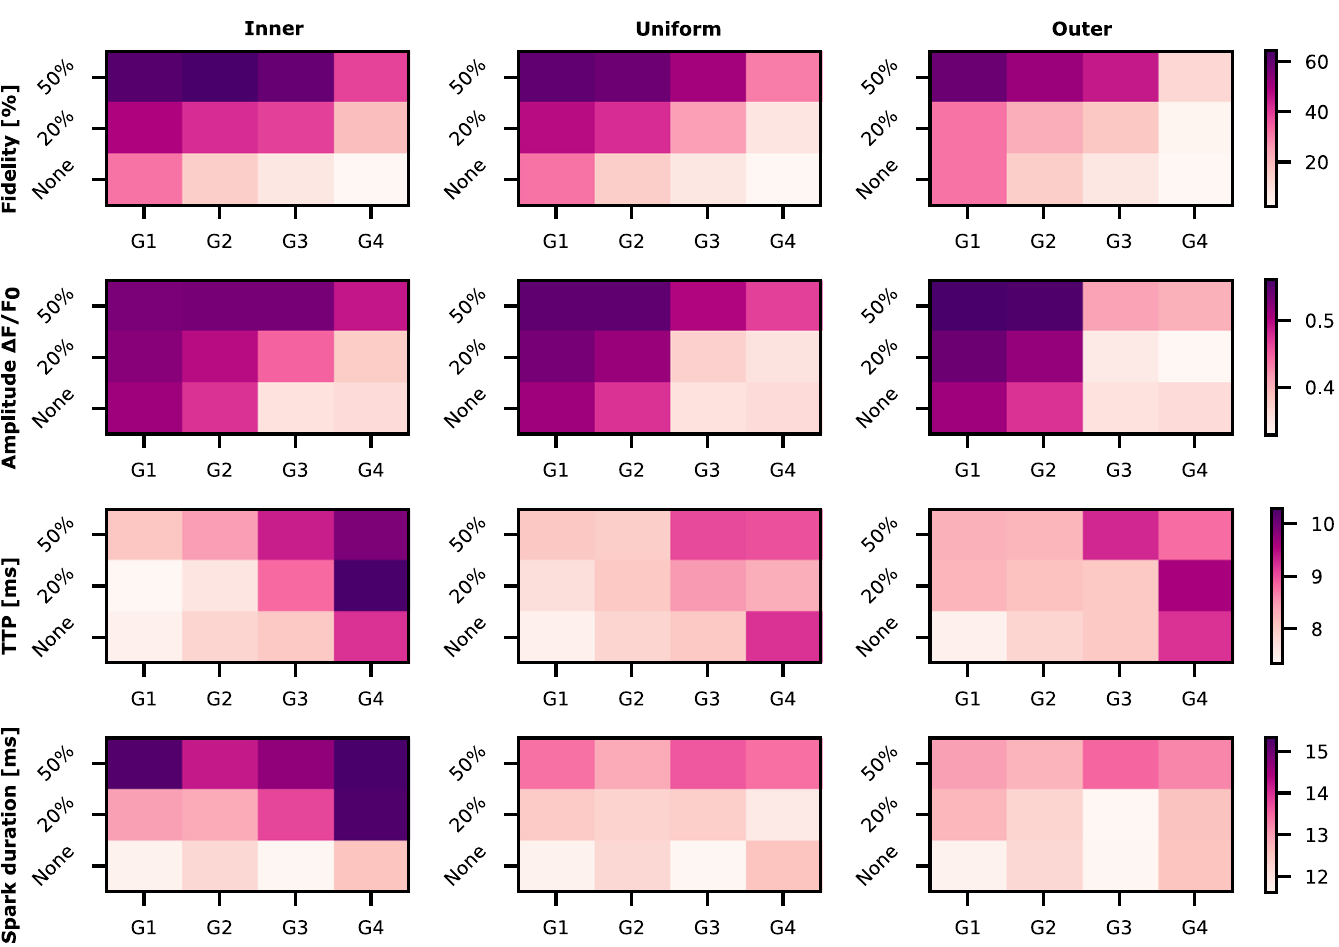
Fig 9. Heat maps depicting a summary of the Ca 2+ spark properties for different phosphorylation patterns. The rows show the different spark properties (fidelity, amplitude, TTP and spark duration) that were analyzed. The columns represent the different phosphorylation patterns studied in this work. Ca 2+ spark properties depend on RyR cluster geometry, cluster integrity, and spatial organization of